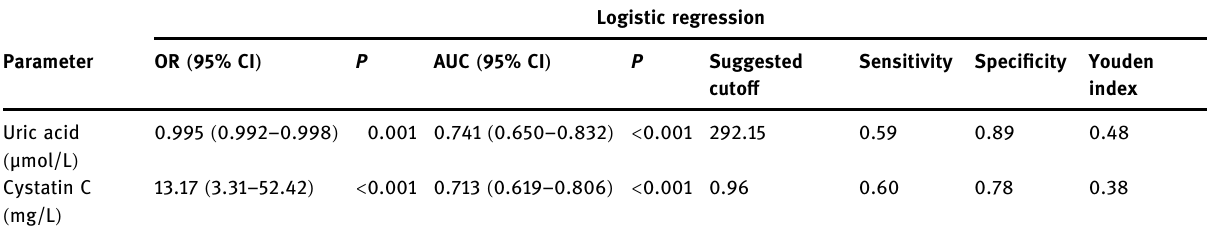
AUC, area under the receiver operating characteristic ( ROC ) curve; CI, con fi dence interval; OR, odds